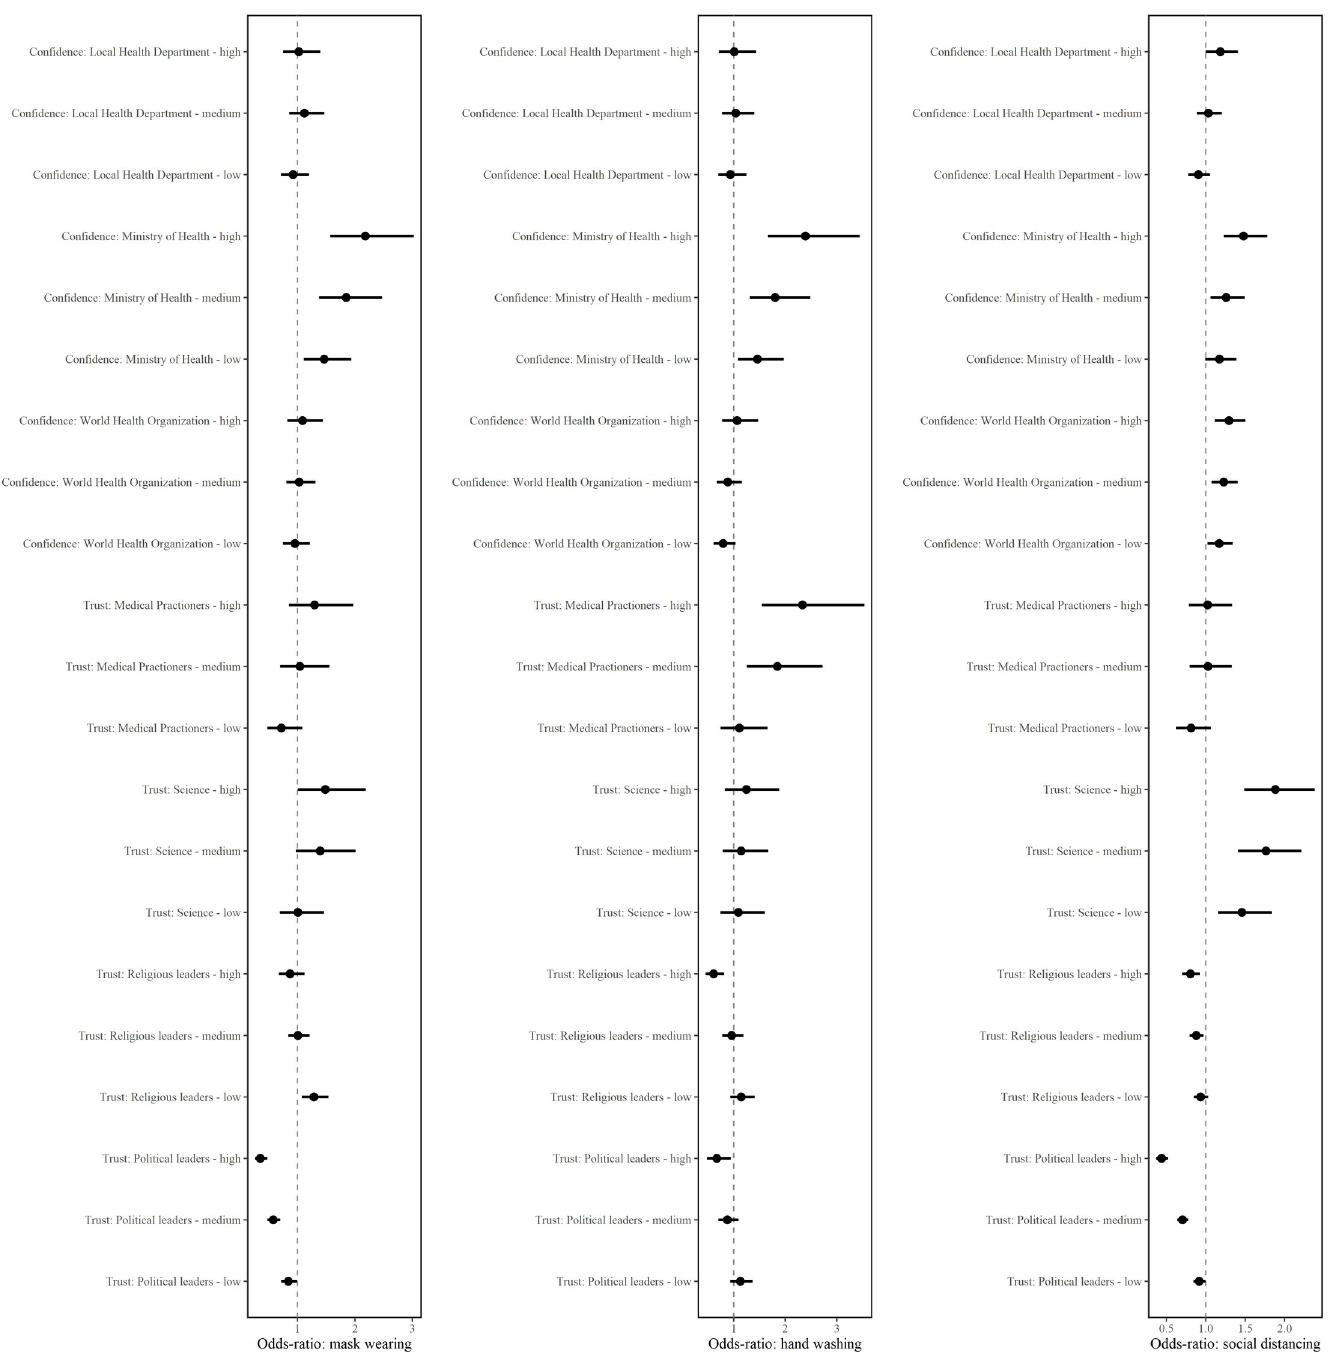
Fig 4. Multivariable modeling of confidence, trust, and adoption of mitigation behaviors. Results from estimating the relationship between confidence and trust measures and vaccine hesitancy using logistic regression. These multivariable models also include age, education, socioeconomic status, gender, risk perception, perception of government policies, personality traits, and country-fixed effects. Please refer to the Methods section of the paper for details on individual variables and to S2 Table for the full results from these specifications.